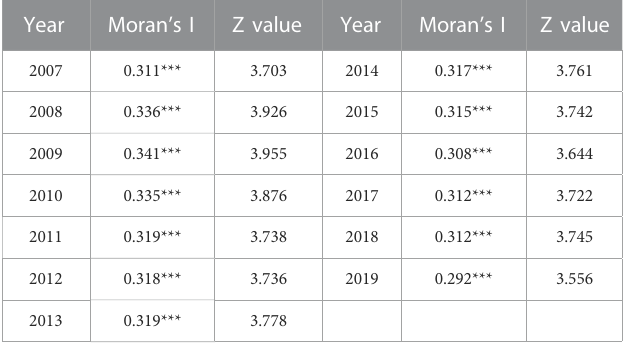
TABLE 4 Moran ’ s I index of energy intensity for 2007 – 2019 .